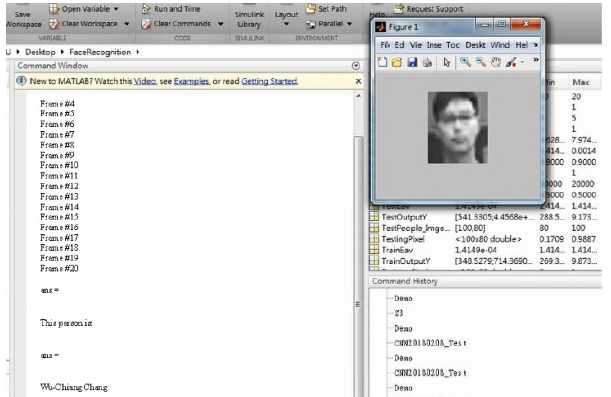
Figure A3. The result of real-time face detection.